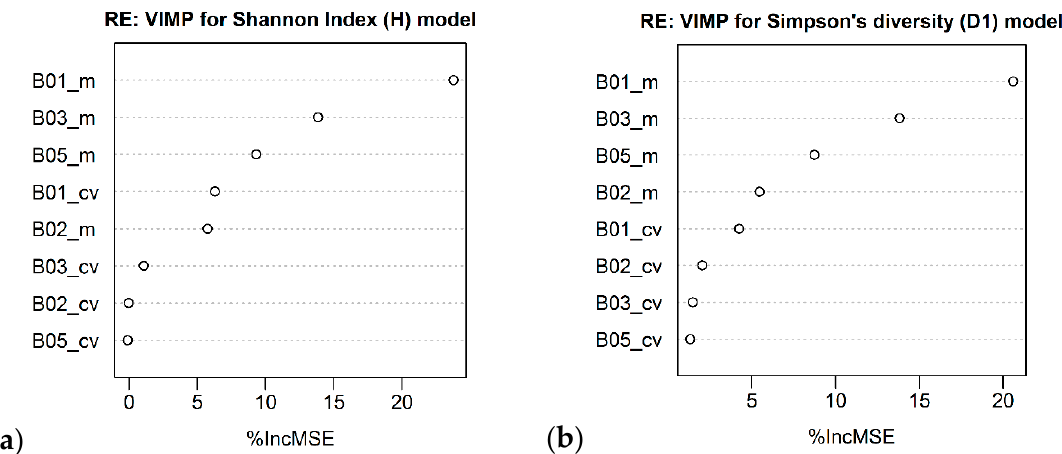
Figure 4. Importance of RapidEye bands using the percentage increase in mean squared prediction error (%IncMSE) for ( a ) Shannon’s ( H’ ) and ( b ) Simpson’s diversity ( D1 ) indices prediction. Higher %IncMSE indicates greater variable importance.